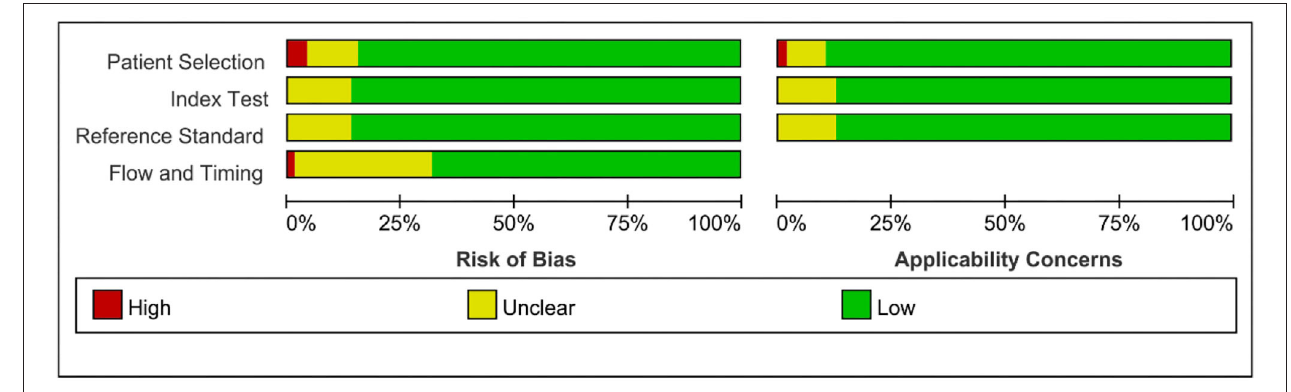
FIGURE 2 | Risk of bias and applicability concerns on the QUADAS-2 tool of the included studies.